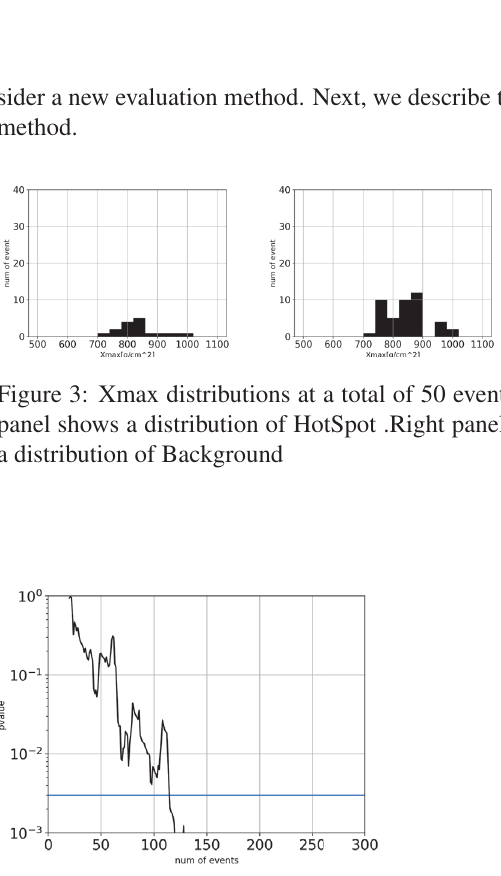
Figure 4: P-value from the comparison between the HotSpot and Background Xmax distributions every 10